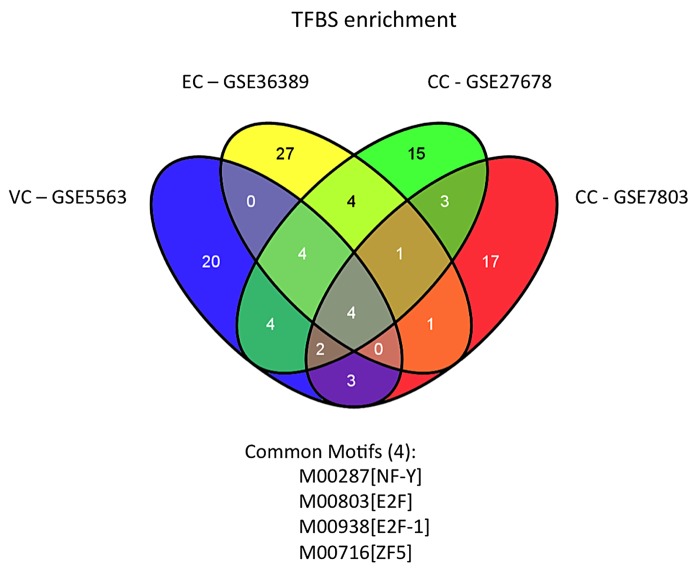
Transcription factor binding analysis in various gynecological cancer expression profiles revealed enrichment of E2F/NFY module.Analysis of microarray expression profile studies conducted in various gynecological cancers, revealed that E2F/NFY module is enriched in all gynecological cancers. Genes that were differentially expressed in GSE5563, GSE7803, GSE27678 and GSE36389 datasets, utilizing the same methodology as described in our study, were used for TFBS enrichment analysis. Common transcription regulators identified in all gynecological cancers exhibited a significant enrichment of E2F/NFY module in gynecological cancers.